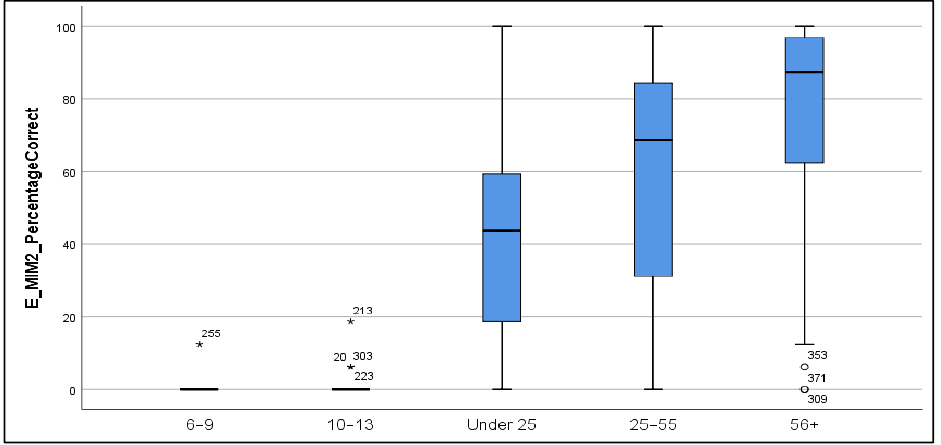
Figure 7. E-MIM Subtest 2 (N + Adj): Accuracy of child and adult participants by language back- ground (* = extreme value)